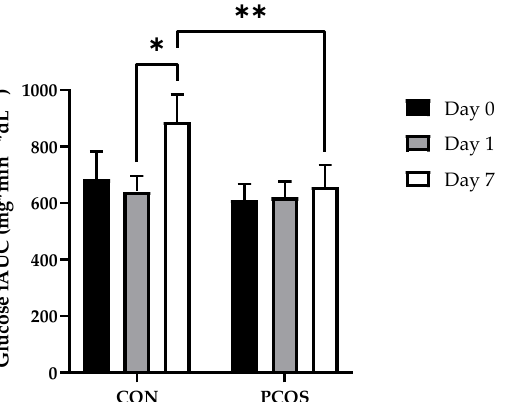
Figure 3. Glucose iAUC mean values ( ± SE) in CON ( n = 15) and PCOS ( n = 14). * = significance between days; ** = significance between groups for day, p < 0.05. CON = non-PCOS women; iAUC = incremental area under the curve; PCOS = women with polycystic ovarian syndrome.